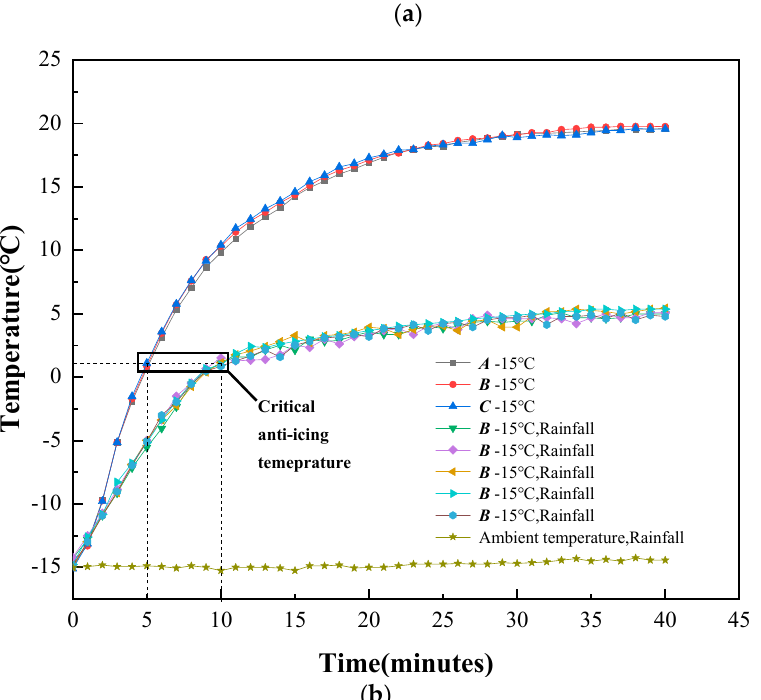
Figure 12. ( a ) Test process during the no pre-heating anti-icing test; ( b ) temperature rise rules of the heating system with or without rainfall: A, B, and C represent the three thermocouples and − 15 °C is the ambient temperature.